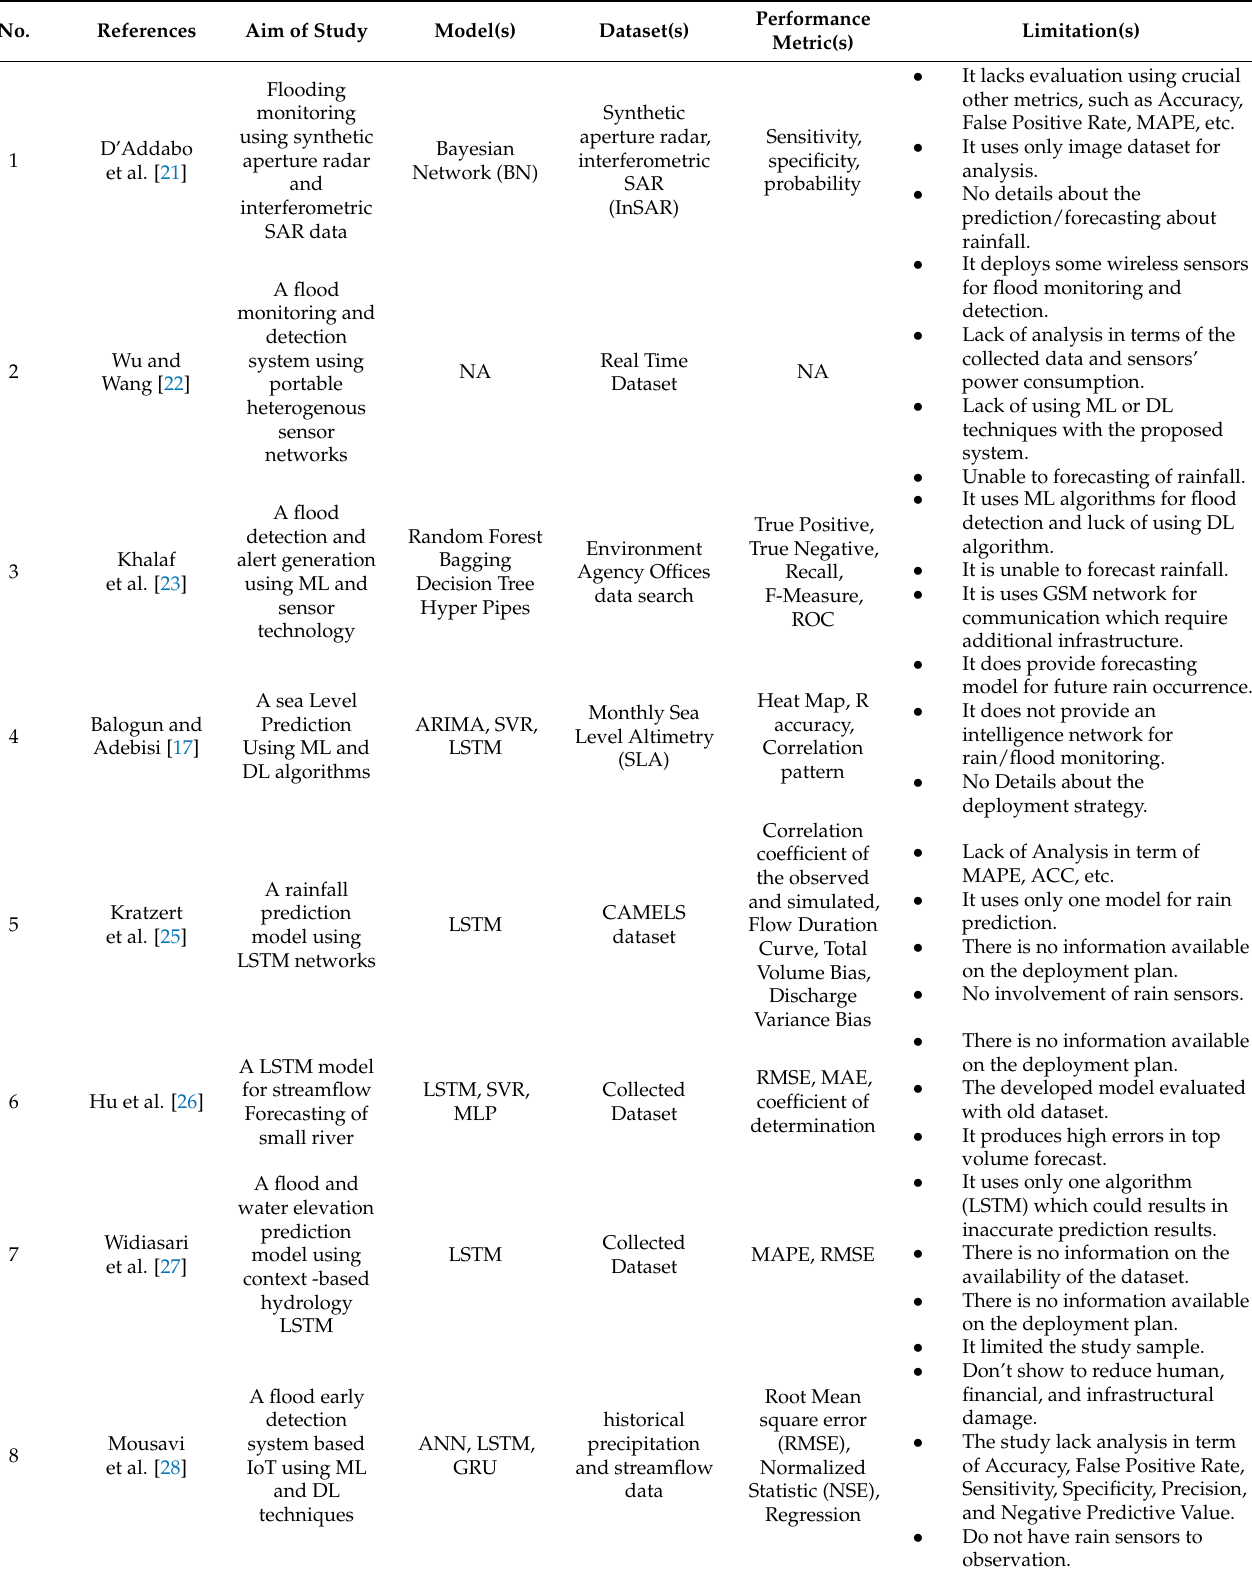
Table 1. Summary of related